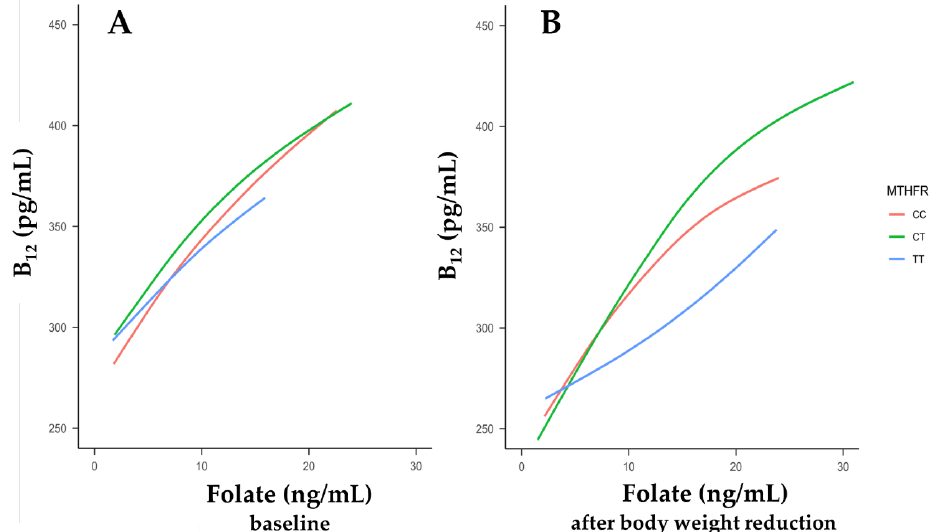
Figure 3. The relationships between serum vitamin B 12 concentrations and folate levels according to the methylenetetrahydrofolate reductase (MTHFR) C677T genotype. Smoothing curves were drawn between B 12 levels and folate levels at baseline ( A ) and after body-weight reduction ( B ).